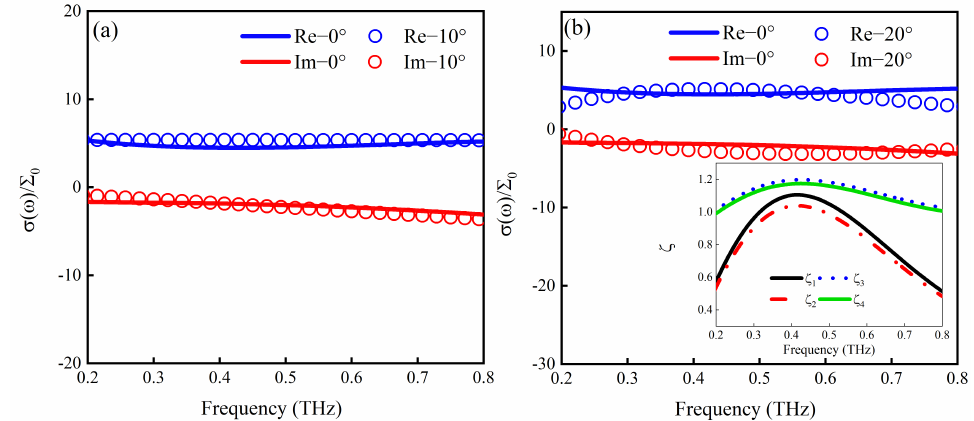
Figure 5. ( a ) The optical conductivity of ML MoS 2 extracted from the TDTS at θ in = 10 ◦ and ( b ) θ in = 20 ◦ for p - polarization. The result for θ in = 0 ◦ is also shown for comparison. Inset: ζ 1 = σ 1 ( Re − 20 ◦ ) / σ ( Re − 0 ◦ ) , ζ 2 = σ 2 ( Re − 20 ◦ ) / σ ( Re − 0 ◦ ) , ζ 3 = σ 3 ( Re − 10 ◦ ) / σ ( Re − 0 ◦ ) ,